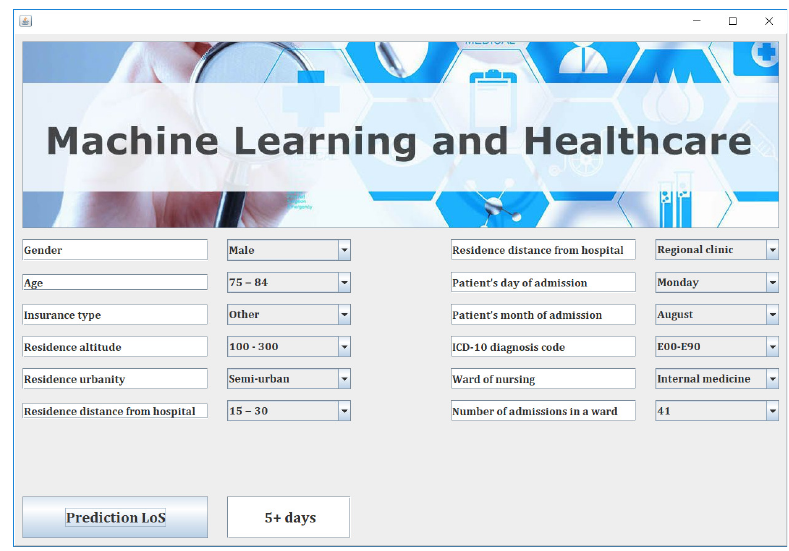
Figure 3. Decision support system for forecasting patients’ length of